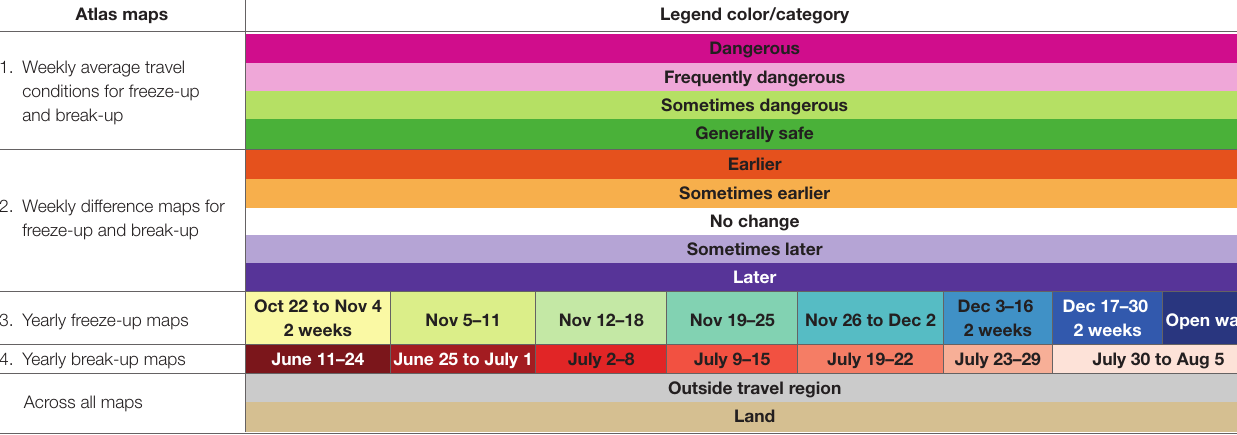
TABLE 5 | Mittimatalik siku asijjipallianinga legend categories and color schemes. Atlas